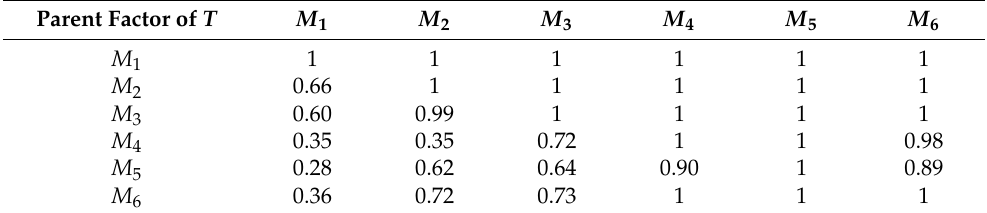
Table 7. Judgment matrix of the parent factor layer to the target layer T .